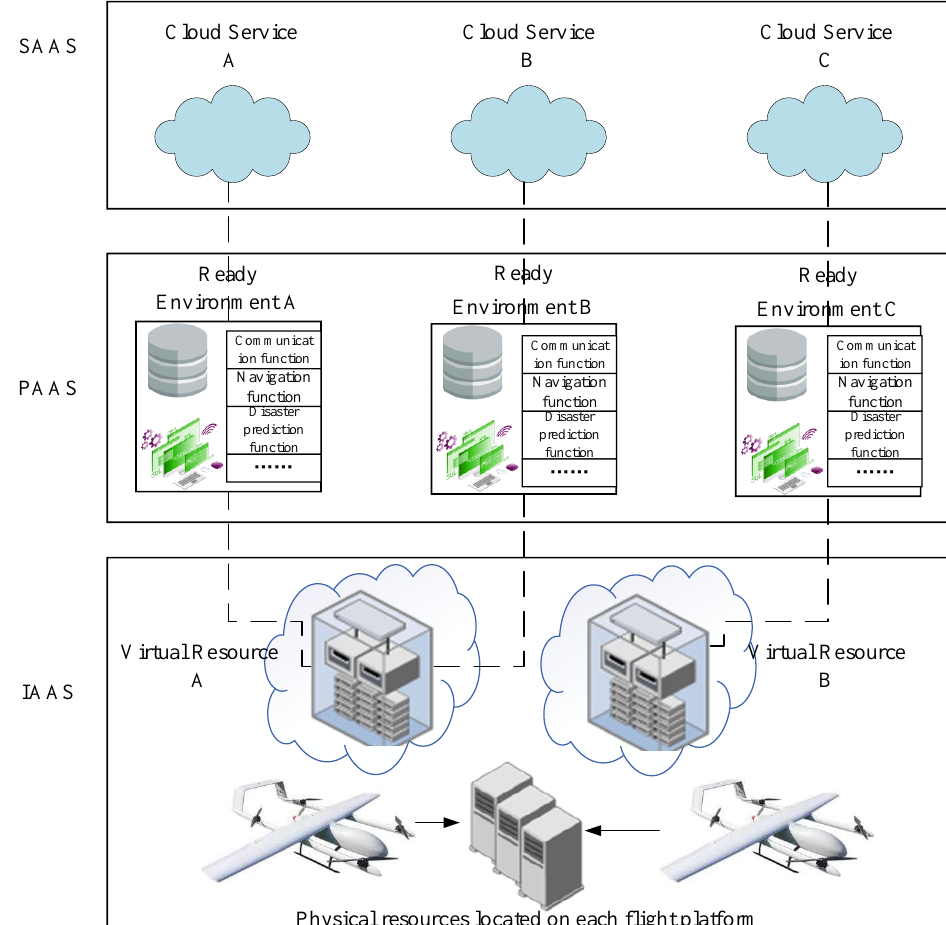
Figure 1. Avionics Cloud IaaS, PaaS, SaaS layered view.